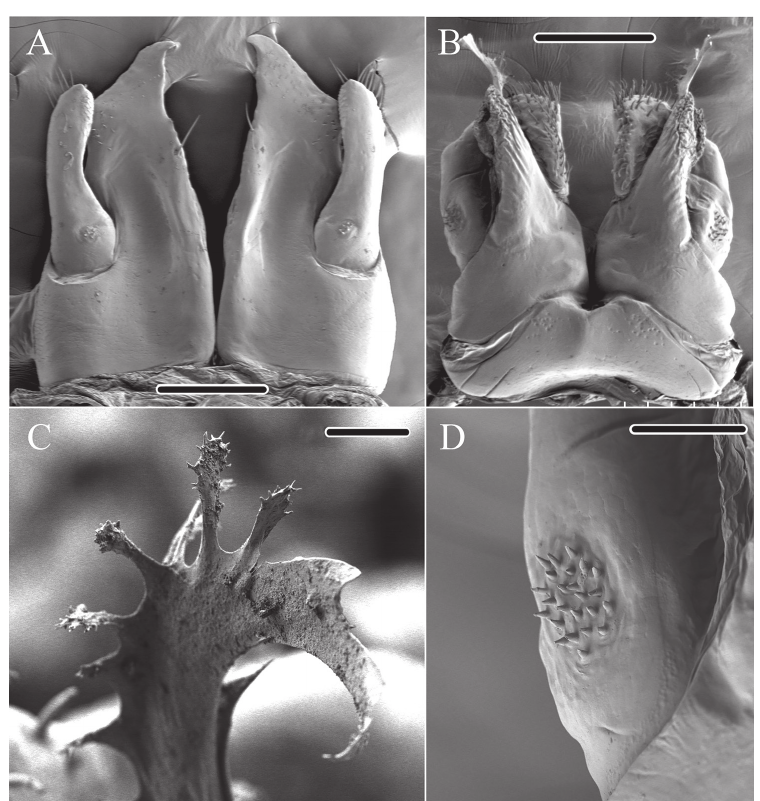
Figure 5. Glyphiulus foetidus sp. n., paratype. A anterior gonopods, caudal view B posterior gonopods, caudal view C flagellum of posterior gonopods D microsetae at lateral margin of posterior gonopods. Scale bars: A, B 0.2 mm C, D 0.02